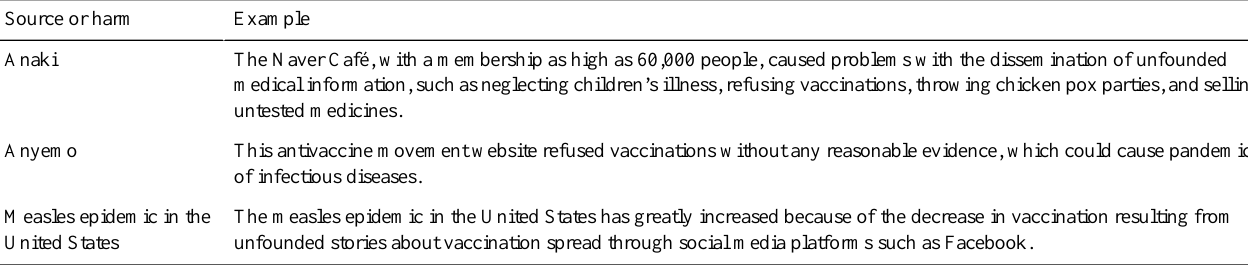
Table 4. Risk cases for dissemination of unverified